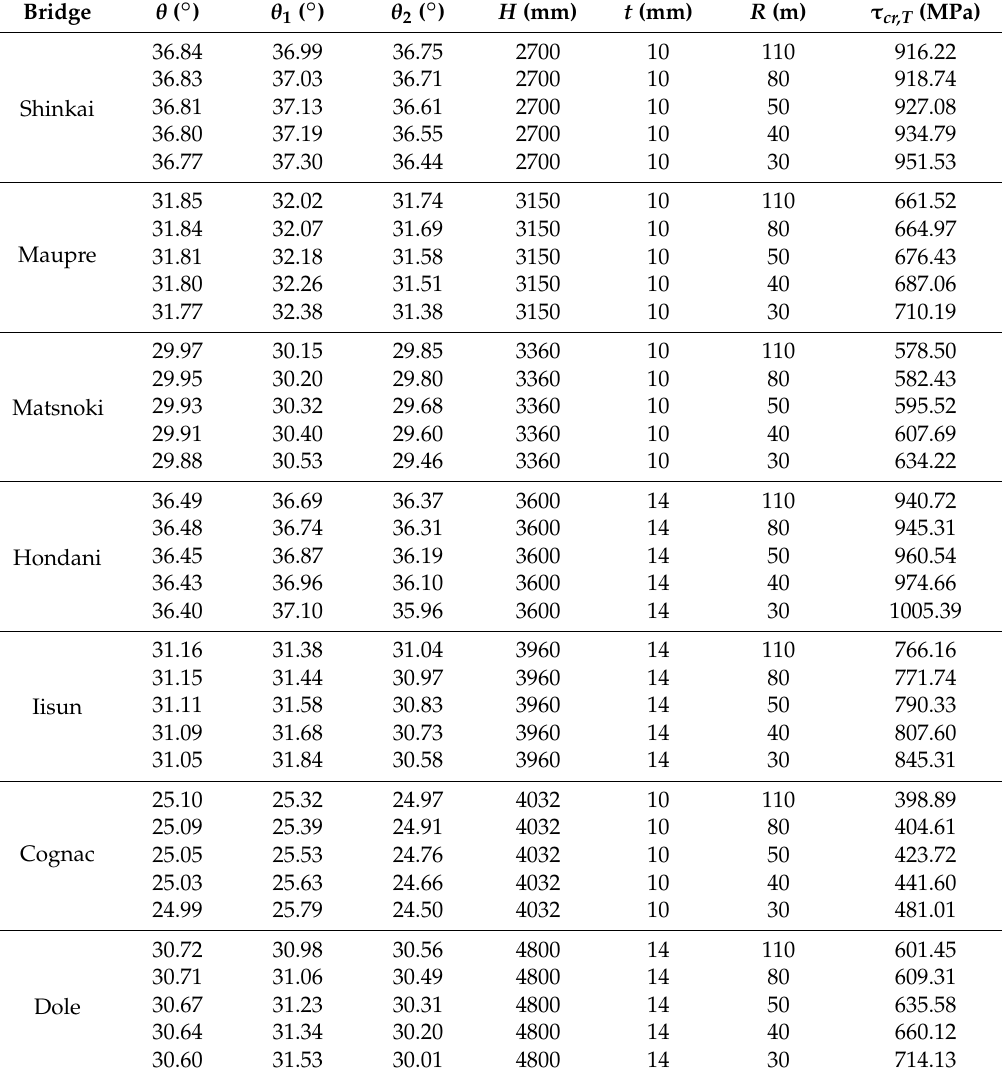
Table 8. Global elastic shear buckling strength of PCCSW with different angles and curvature radii.